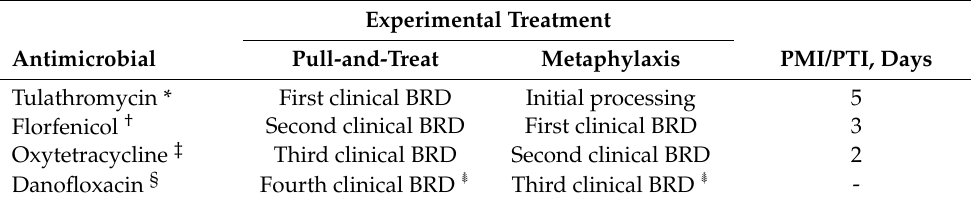
Table A1. Timing of antimicrobial administration for the control and treatment of bovine respiratory disease (BRD) and respective post-metaphylactic or -treatment intervals (PMI or PTI) for steers and heifers at medium risk for BRD in the clinical trial.